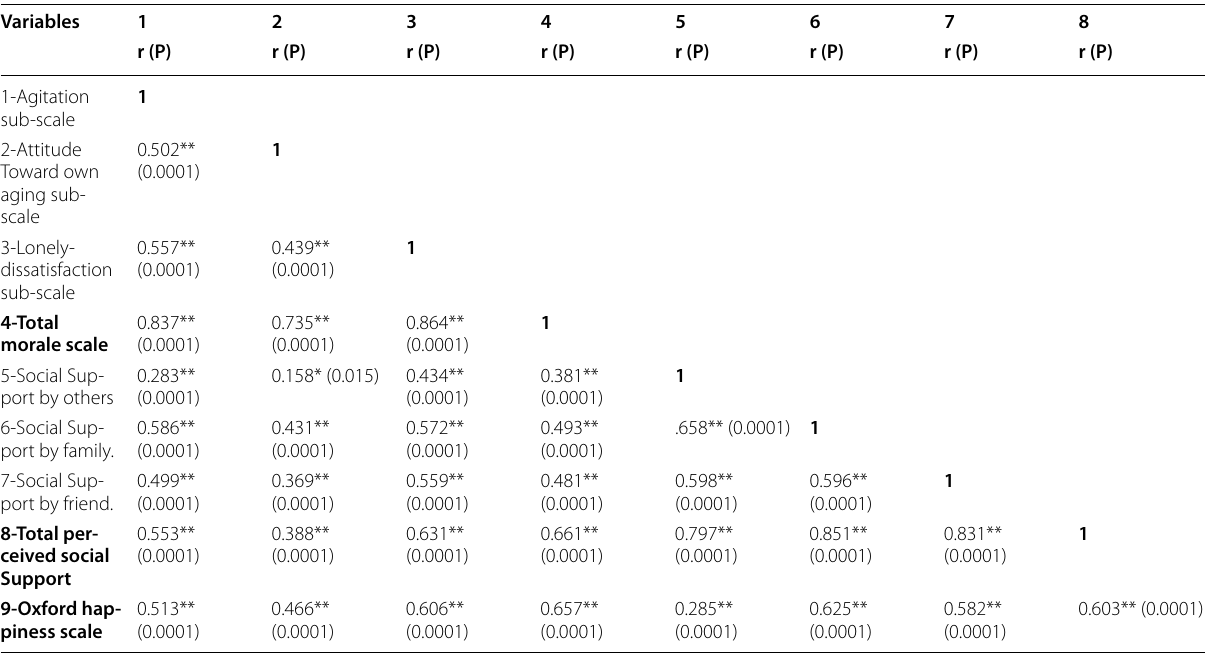
Table 7 Correlation matrix between, elderly morality score and its subscales, elderly social support score and its subscales, and happiness score of studied elderly ( n =